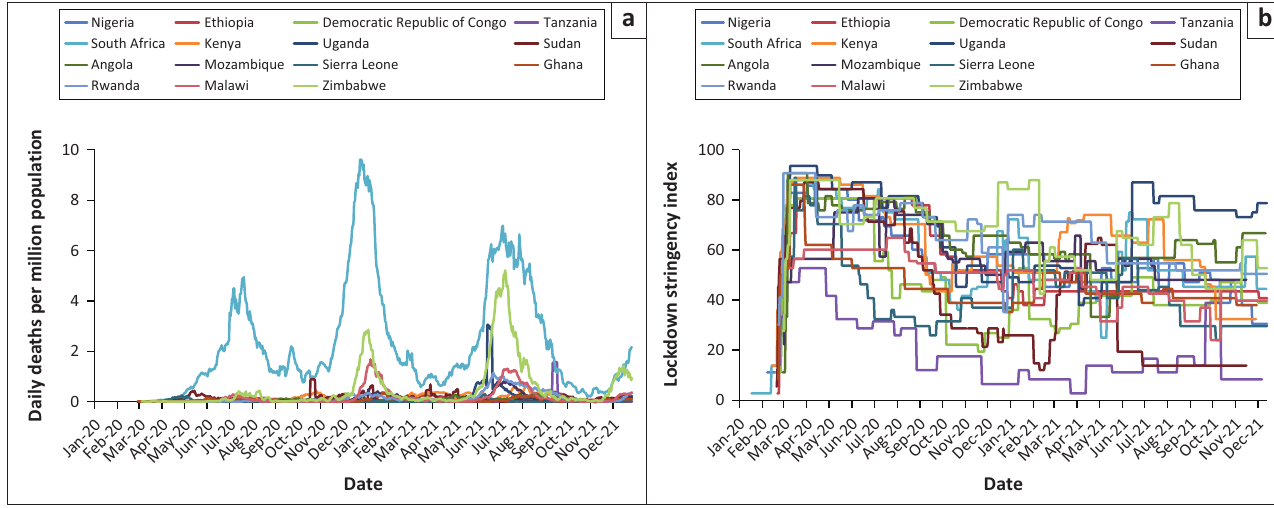
Source : Our World in Data (https://ourworldindata.org/coronavirus); Centre for Systems Science and Engineering (https://www.arcgis.com/apps/dashboards/bda7594740fd40299423467b48e9ecf6) Note: (1) Sub-Saharan African country selection includes the top 10 largest populations and the home countries of Delphi panellists; (2) The ‘lockdown stringency index’, developed by the Oxford Coronavirus Government Response Tracker project, is calculated as the mean score of nine response metrics: school closures, workplace closures, cancellation of public events, restrictions on public gatherings, closures of public transport, stay-at-home requirements, public information campaigns, restrictions on internal movements and international travel controls. Scores take a value between 0 and 100 (100 = strictest response). FIGURE 1: Normalised COVID-19 contagion and lockdown stringency in selected sub-Saharan African countries ( n =